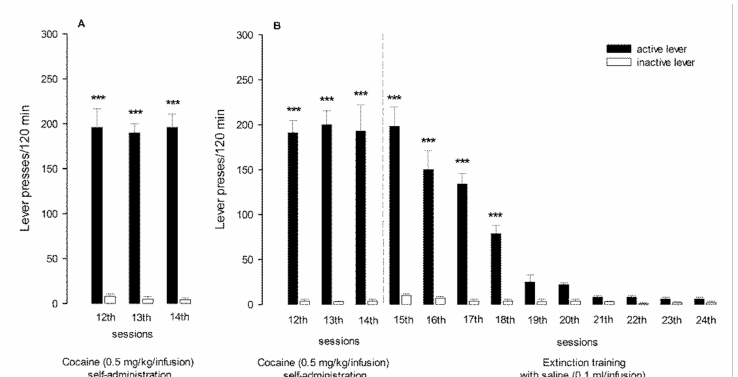
Figure 3. The number of active and inactive lever presses during the last 3 days of cocaine self- administration ( A ) as well as during the last 3 days of cocaine self-administration and following 10 days of abstinence with extinction training ( B ): the number of rats per group, n = 10. Data are presented as the mean ± SEM, *** p < 0.001 vs. inactive